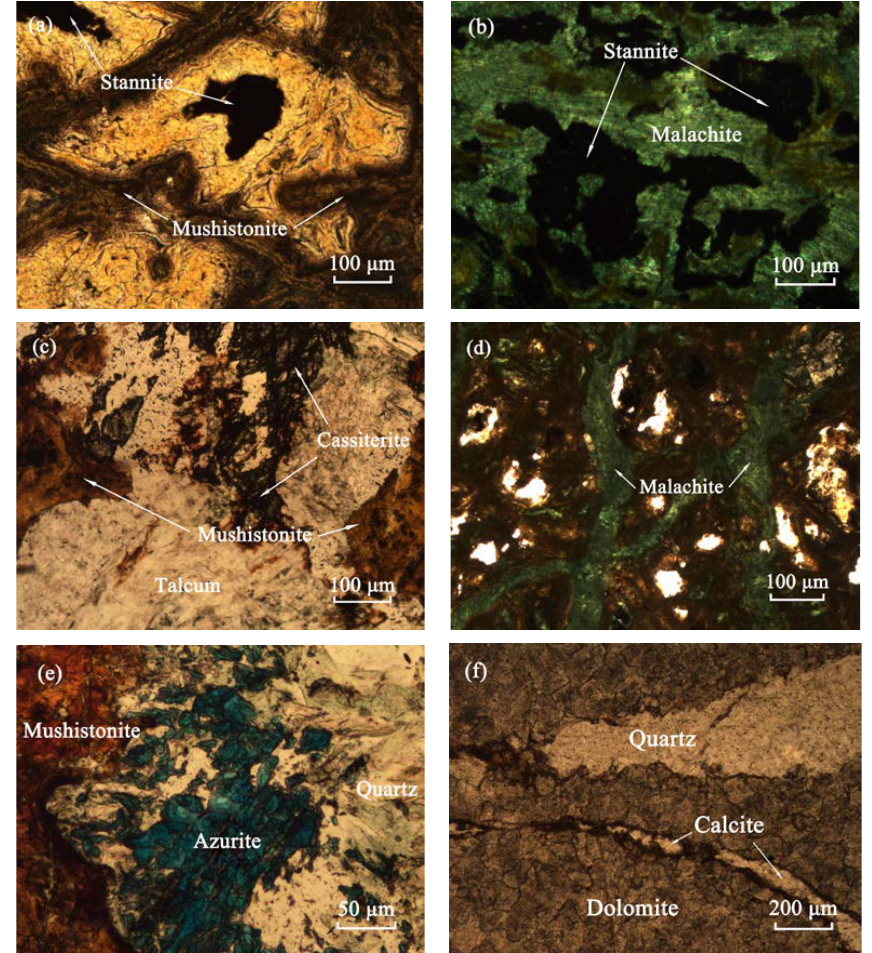
Figure 2. Optical microscope images of the raw ore, dissemination characteristic of main minerals.